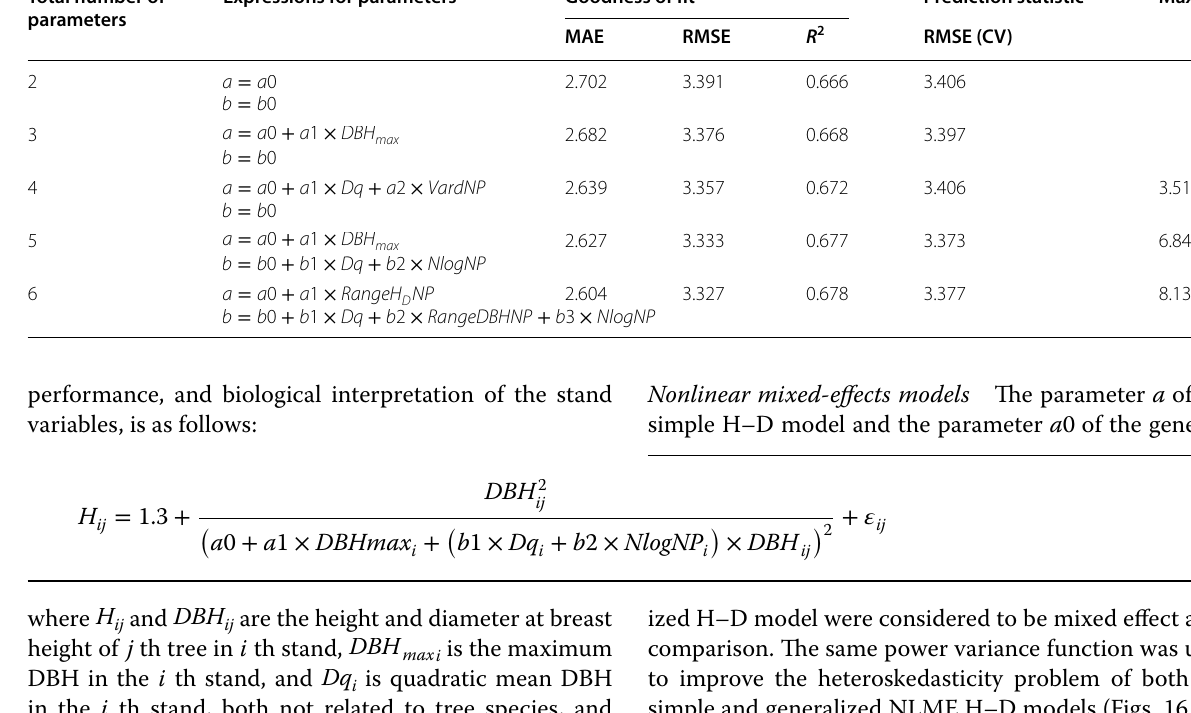
Table 9 Results from the inclusion of stand variables for SM1 NP Total number of Expressions for parameters Goodness of parameters